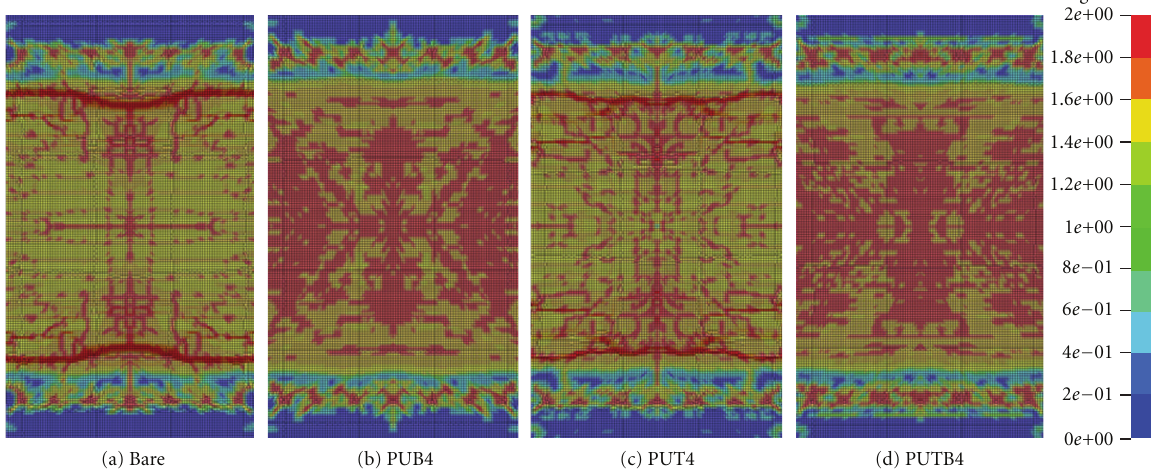
Figure 7: Contours of damage to the concrete elements on the bottom face of selected